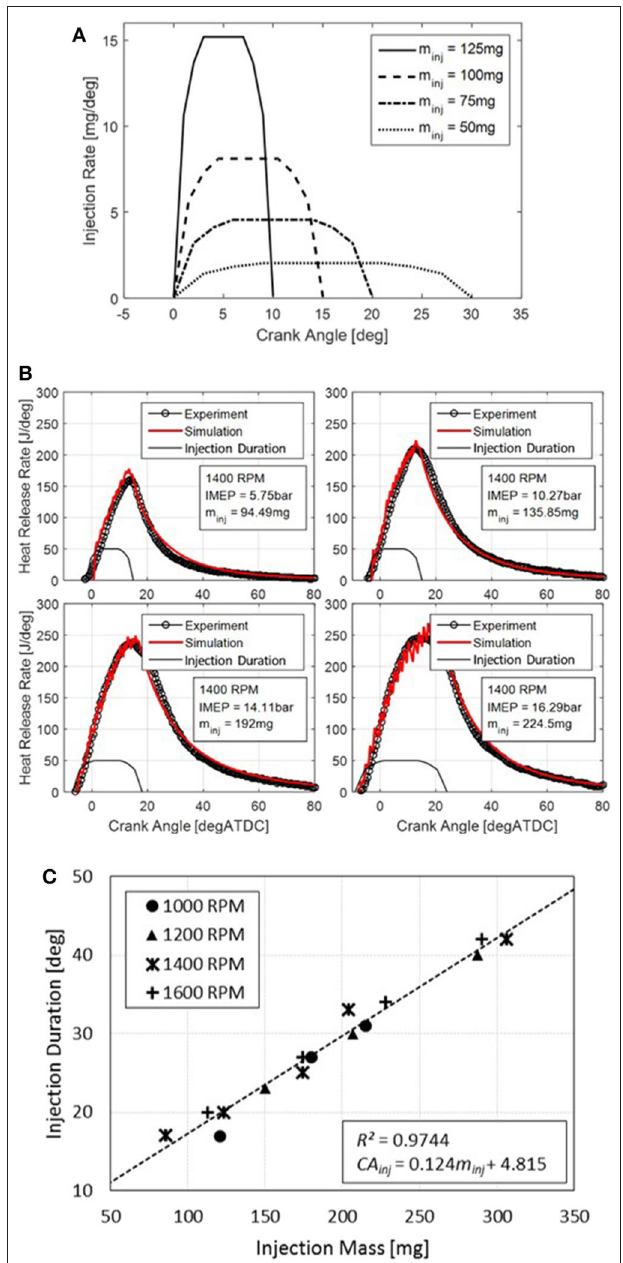
FIGURE 11 | (A) An example of the approximated injection rate model with fixed shaping array and varying injection quantity and duration. (B) Derivation of EOI by matching the experimentally derived heat release profiles using the diesel only combustion model. (C) Linear regression between diesel injection duration and injected